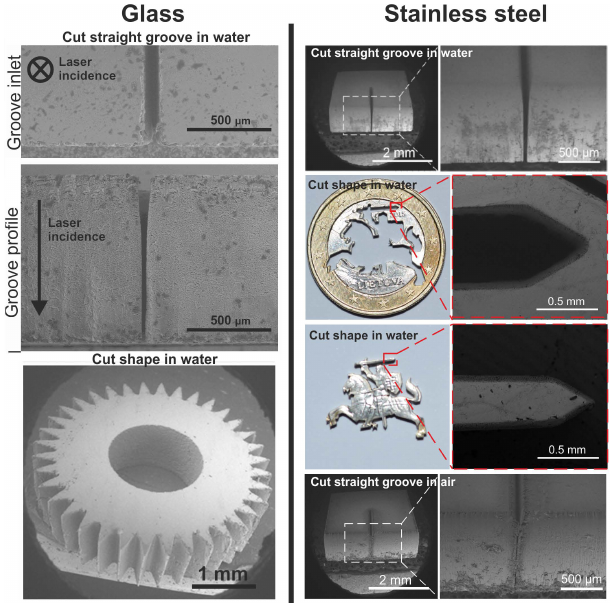
Figure 7. Examples of micromachined glass and stainless steel samples and the cutting of complex shapes. The State Emblem was cut out of a one-euro coin. Optimal fabrication parameters that were used for cutting: average power- 10 W, T = 0.6 mm, R = 33.3 kHz, F = -0.5 mm, S = 300 mm/s. The bottom right image displays the cut stainless steel sample in